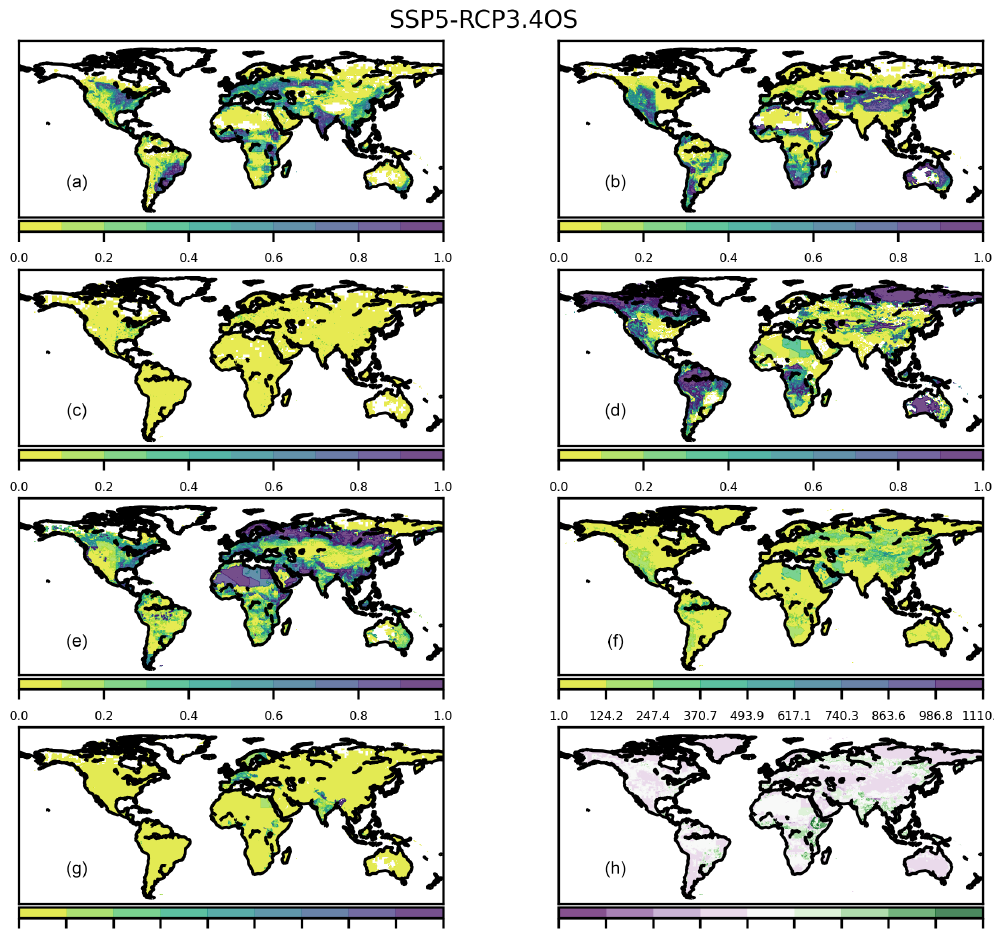
Figure A3. Maps for the year 2100 for the SSP5-RCP3.4OS scenario showing the following: (a) fraction of each grid cell occupied by cropland; (b) the fraction of each grid cell occupied by pasture; (c) the fraction of each grid cell occupied by urban land; (d) the fraction of each grid cell occupied by primary vegetation; (e) the fraction of each grid cell occupied by secondary vegetation; (f) the mean age (in years) of secondary lands in each half-degree grid cell; (g) the mean gross transitions (km 2 yr − 1 ) over a 20-year interval for each grid cell; and (h) the mean net transitions (km 2 yr − 1 ) over a 20-year interval for each grid